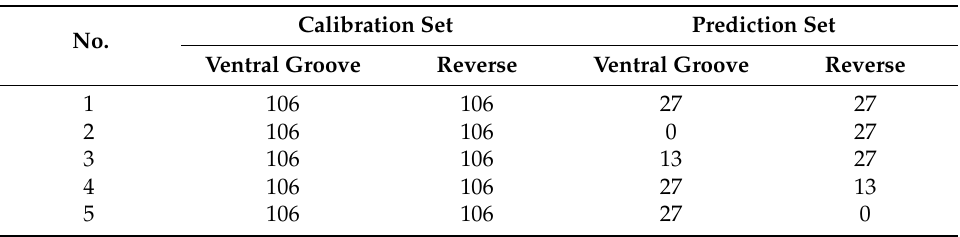
Table 1. Different proportions of the ventral groove side and the reverse side for constructing the calibration set and prediction